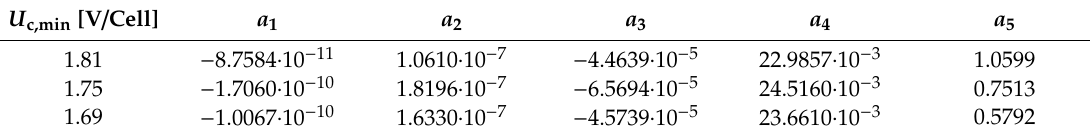
Table 1. Fourth-degree polynomial coe ffi cients for various depths of lead-acid battery discharging. U c,min [V / Cell] a